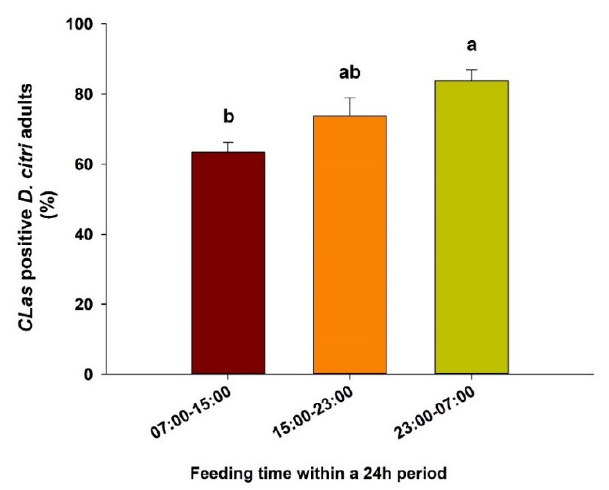
Figure 4. Percentage of C Las-positive D. citri adults feeding on C Las-infected citrus during different periods of the day. The bars display the average over three replications. The standard deviation of the mean is shown by standard error bars. The significance of the treatments at p < 0.05 is shown in lowercase lettering. Similar letters represent no significant difference among the treatments.